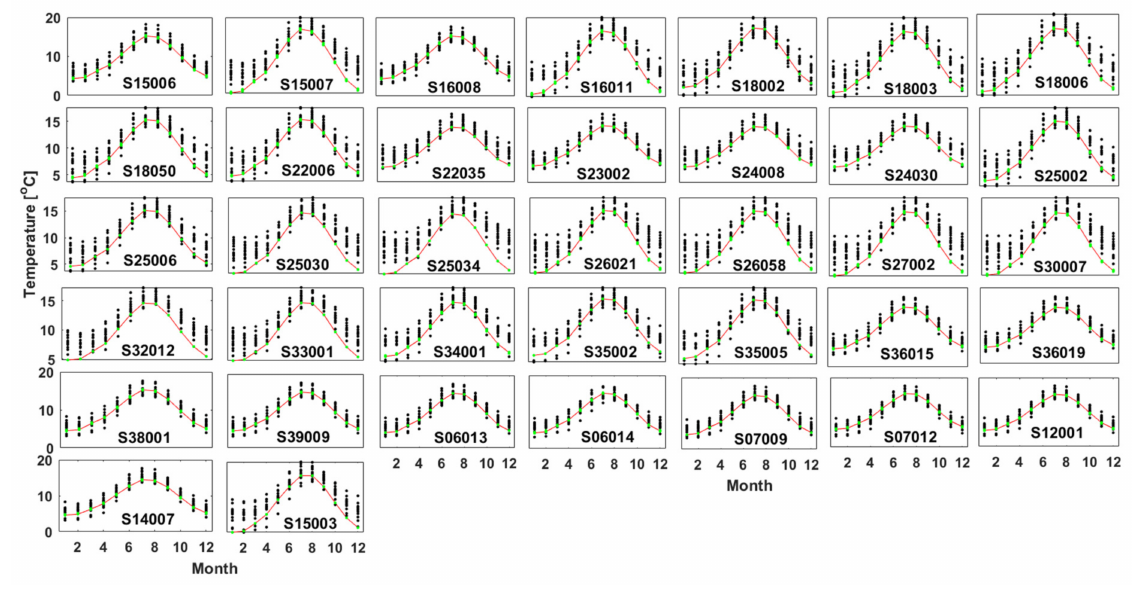
Figure 3. As in Figure 2, but for the monthly mean